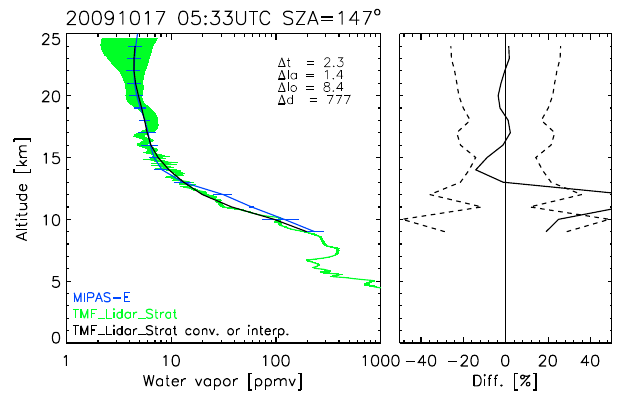
Fig. 8. Same as Fig. 1 but for TMW lidar water vapor profiles; the absolute water vapor VMRs are presented on a logarithmic scale, while the difference and the combined total errors are presented as percentage of the reference profile. For amore detailed description seeFig. 1.